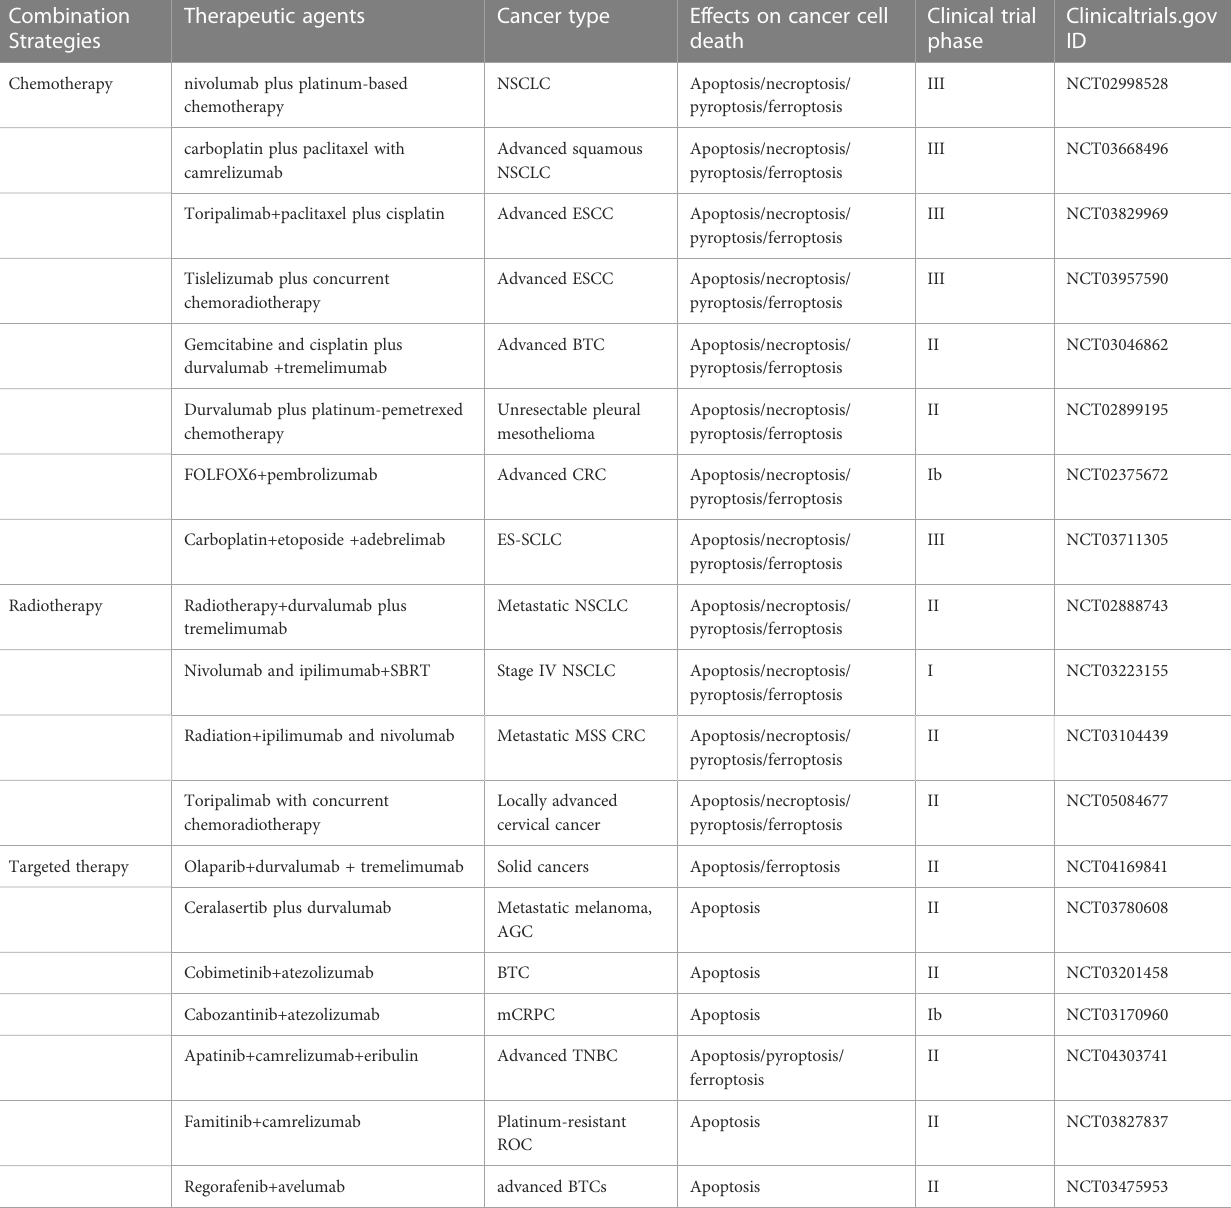
TABLE 1 Summary some of the clinical trials testing combinations of immunotherapy with therapeutic agents that may target apoptosis, necroptosis, pyroptosis, and ferroptosis.